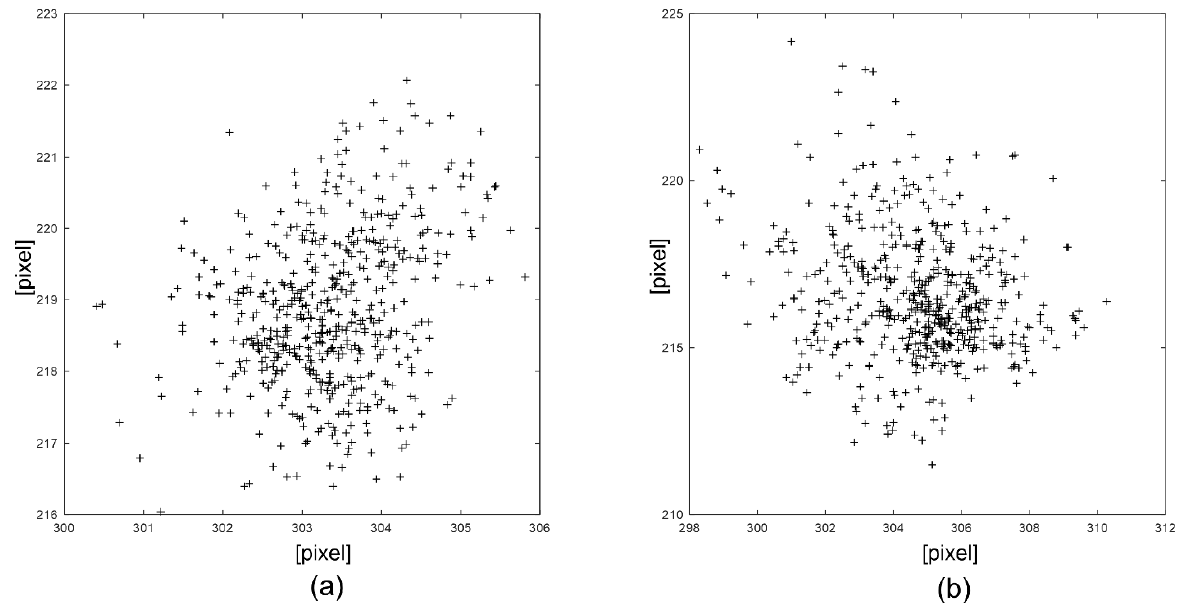
Figure 13. Positions of the centroid of the three vortex point constellations ( a ) using the pseudo-phase method and ( b ) the bifurcated interference fringes method.